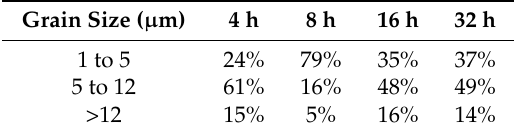
Table 3. Grain size distributions of the 4-h, 8-h, 16-h, and 32-h annealed samples.